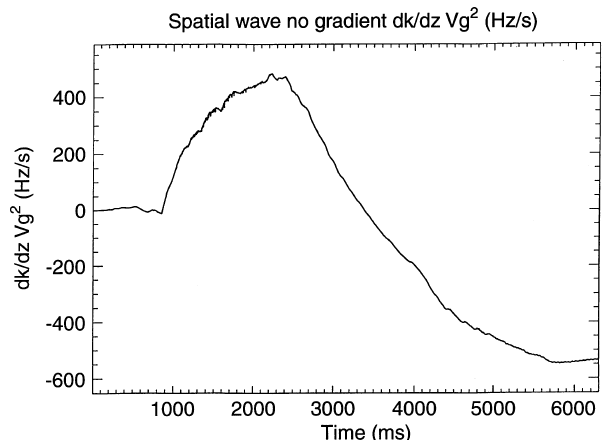
Fig. 18. Case C. Wire diagram of D W at t = 3 s and at z = +200 km. Trapped particle topology is more complex in